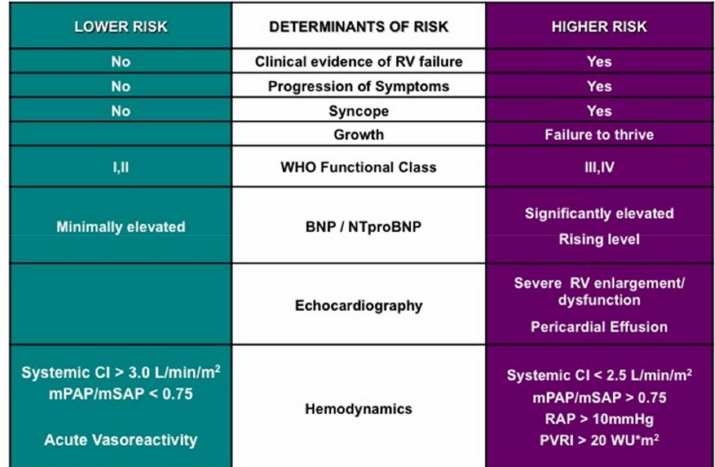
Figure 12. Risk factors that should be considered when planning therapeutic management options in pulmonary hypertension. CI—cardiac index; mPAp—mean pulmonary artery pressure; mSAp—mean systemic aortic pressure; NT-proBNP—N-terminal–pro-brain natriuretic peptide; PVRI—indexed pulmonary vascular resistance; RAP—right atrial pressure; RV—right ventricle; SBNP—serum